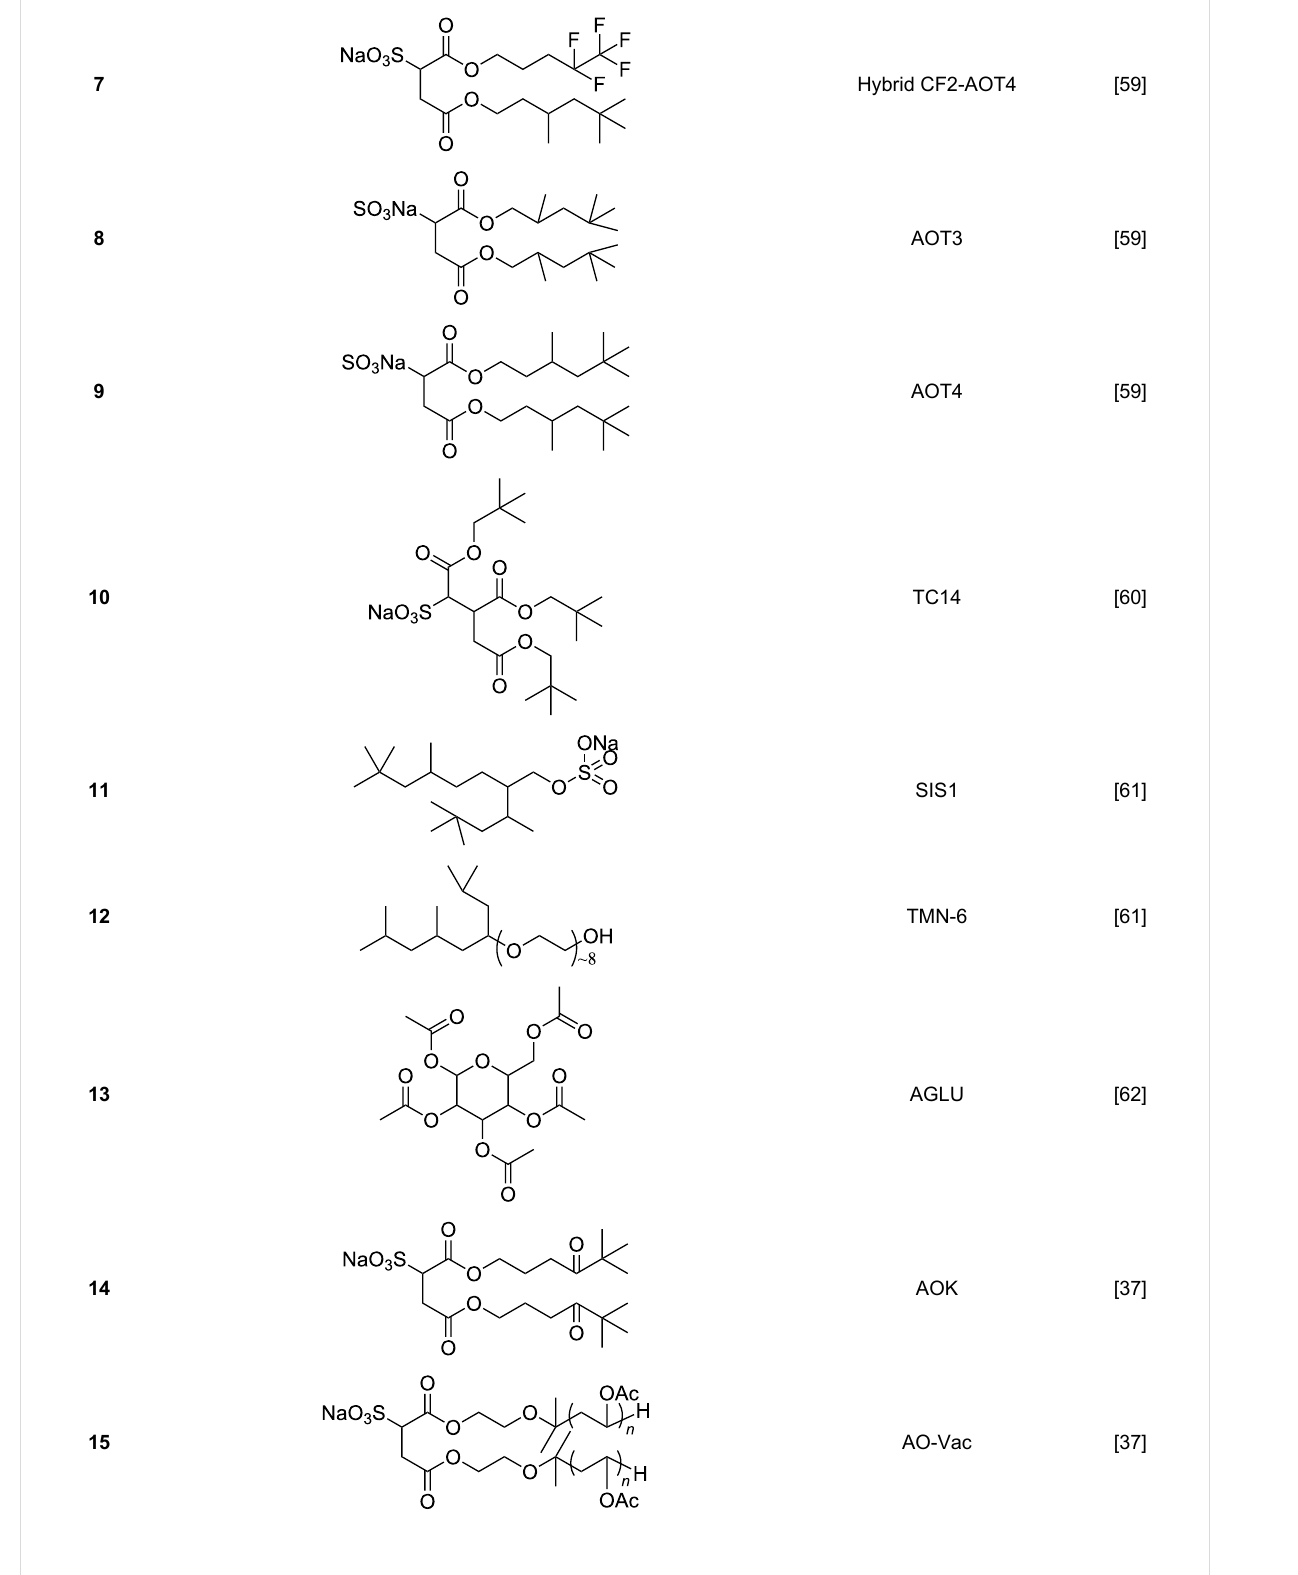
Table 1: Structures of CO 2 -philic surfactants discussed in this review.